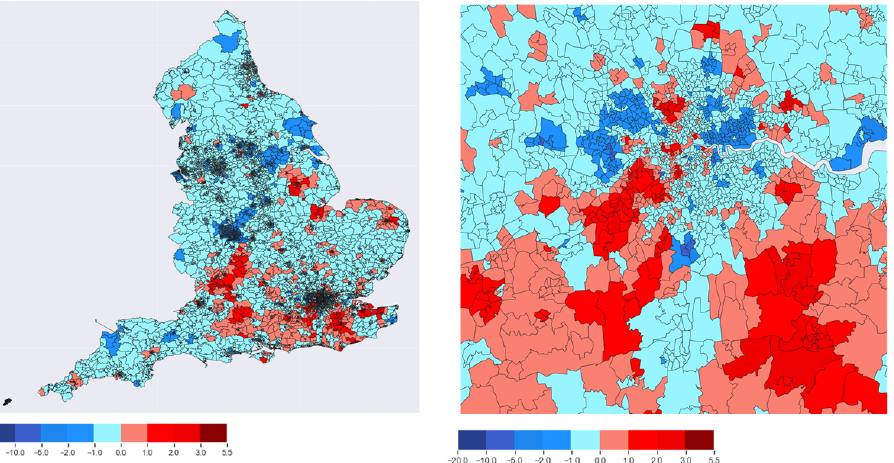
Figure 3. Heat maps indicating loneliness indices of England ( left ) and a zoomed in version of the London area ( right ) based on 2019 data . Here, lower indices indicate lower loneliness